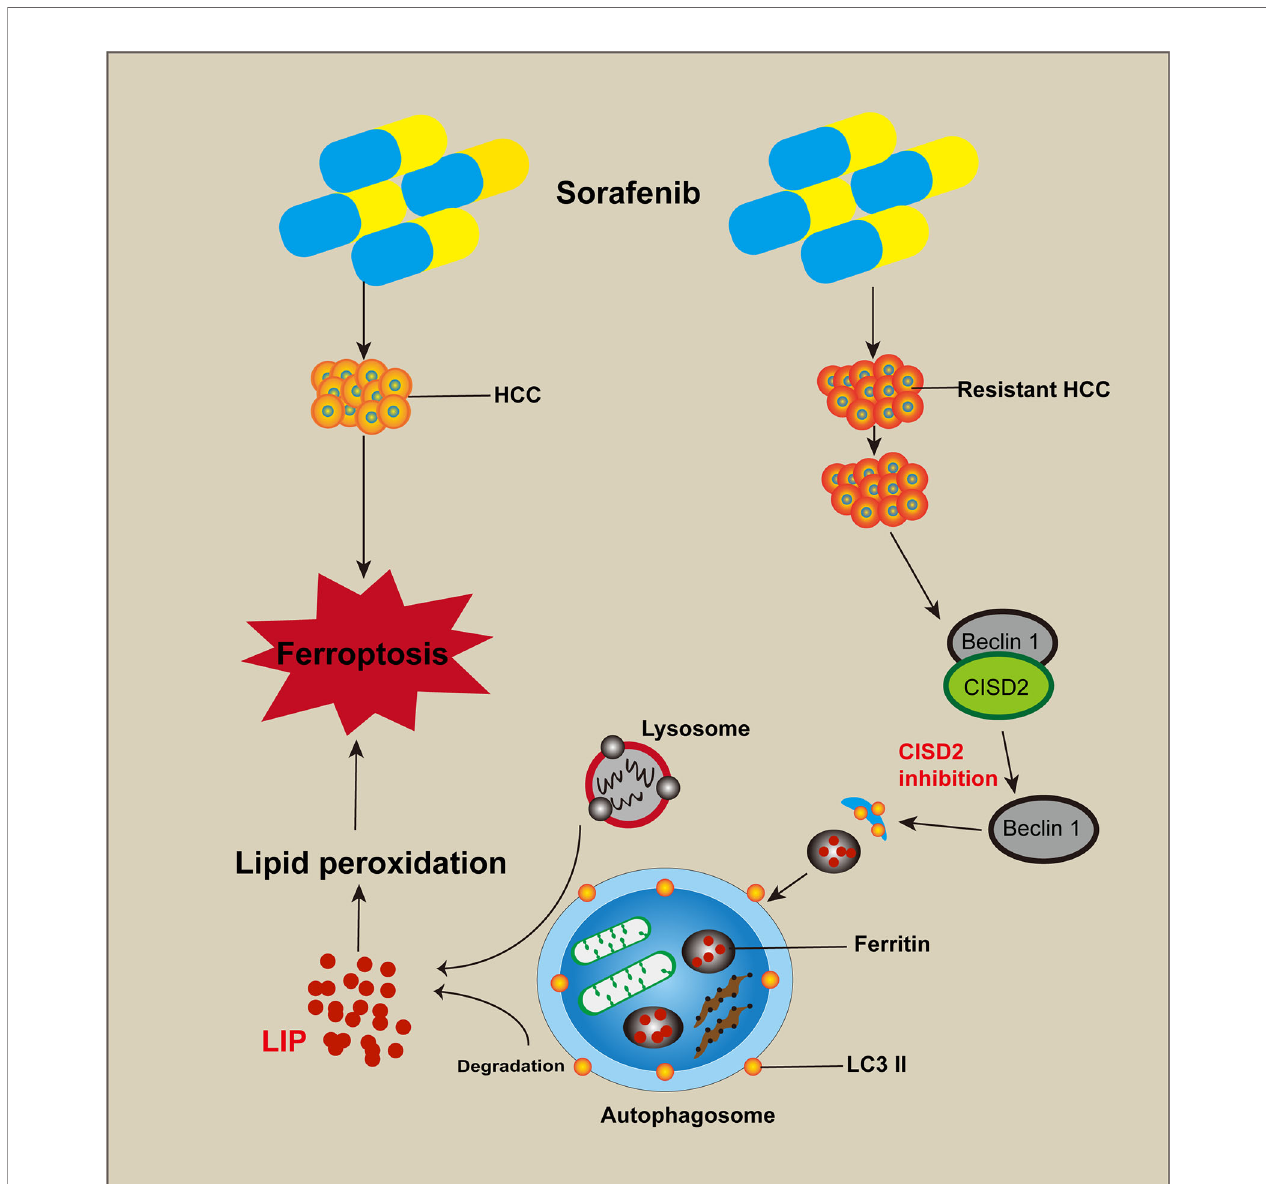
FIGURE 9 | Cartoon diagram of CISD2 promotes resistance to sorafenib-induced ferroptosis by regulating autophagy in hepatocellular carcinoma. Inhibition of CISD2 restored sorafenib-induced ferroptosis and reversed drug resistance, and these effects were related to the inhibition of CISD2-promoted autophagy. Through this process, the excessive activation of autophagy promoted the release of iron ions and induced lipid peroxidation to promote